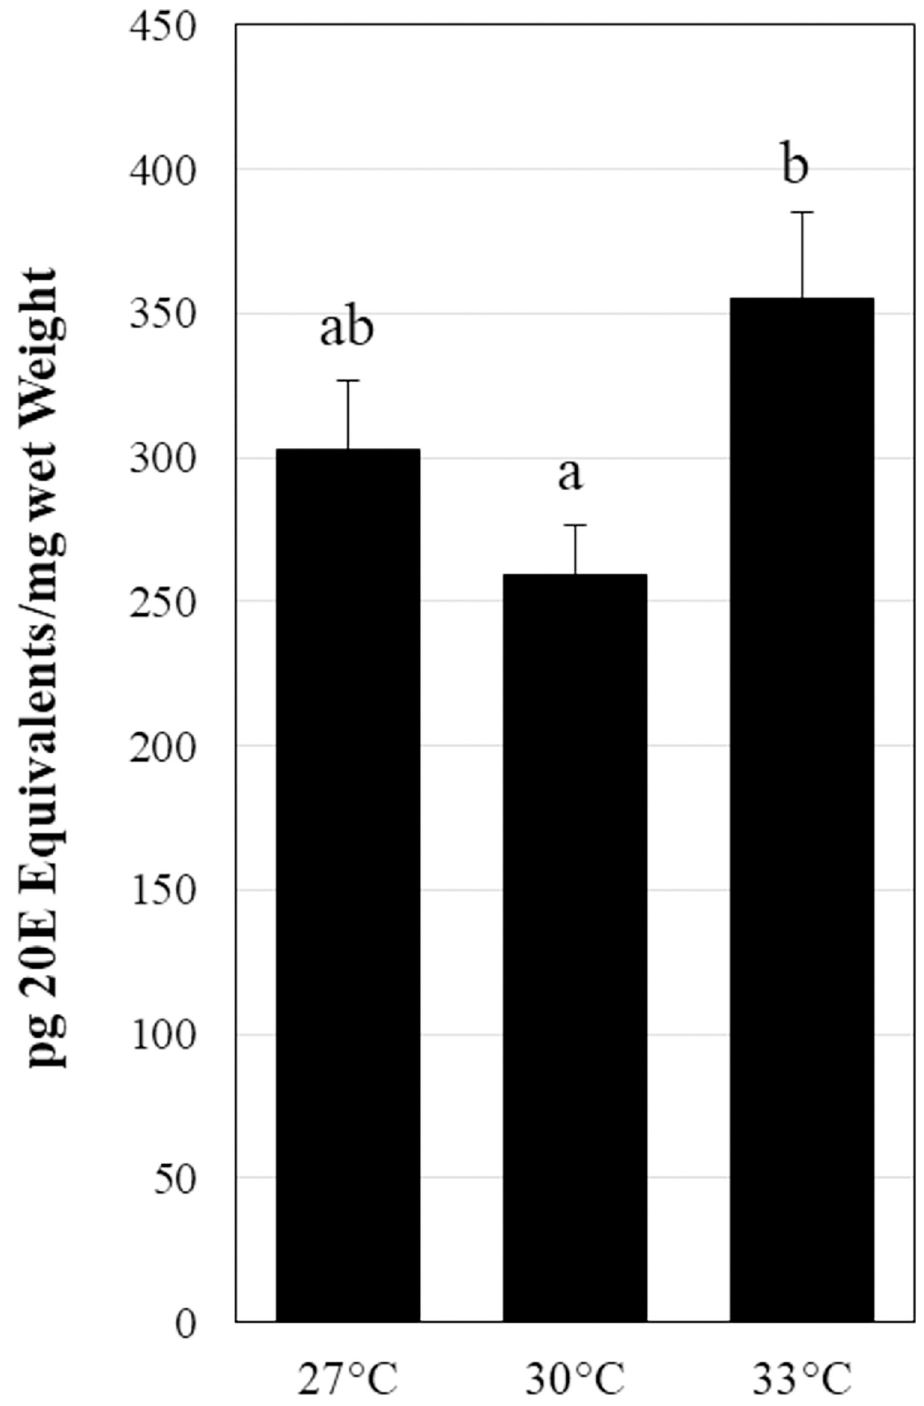
Fig 1. Average ecdysteroid titers during spiderling development. Ecdysteroid titers were determined for spiderlings reared at 27, 30, or 33˚C from 4 days before to 10 days after the second molt that occurred per family at 27˚C. Error bars represent standard